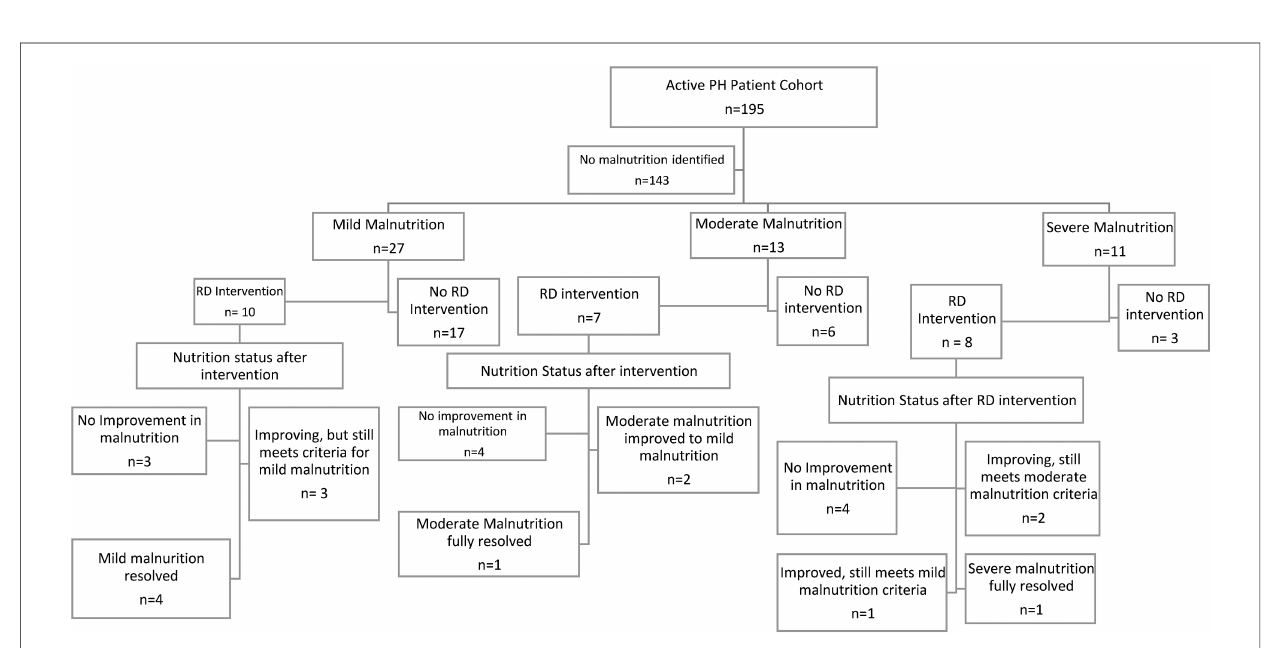
FIGURE 2 Flowchart of